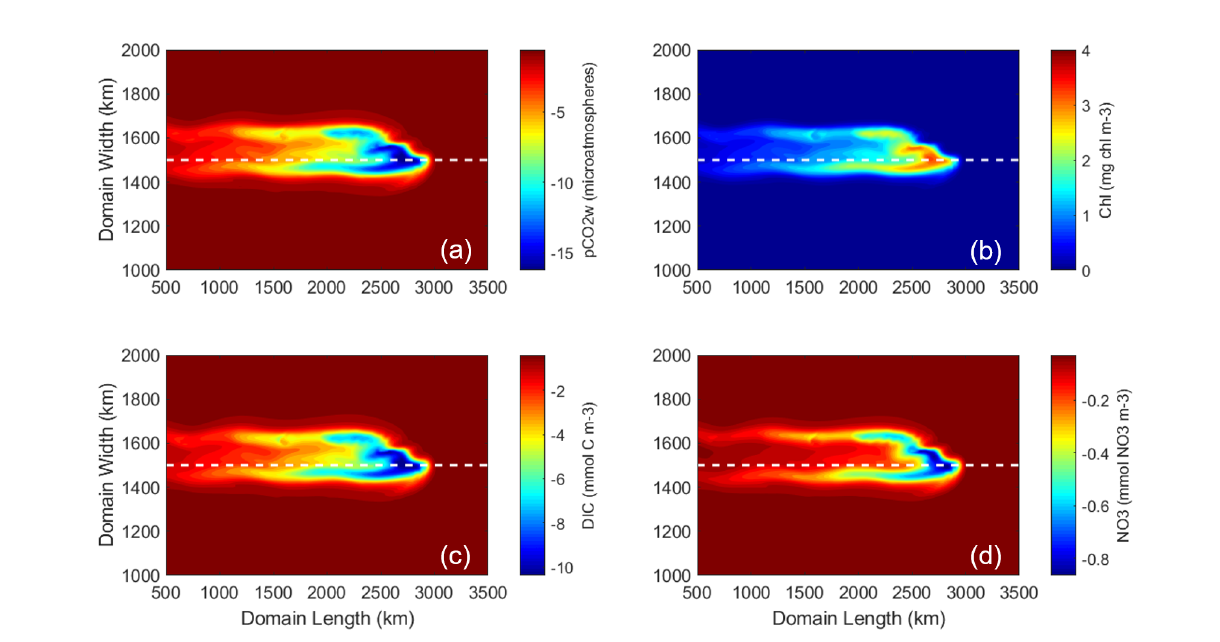
Figure 5. Surface plots of the control simulation results minus S1 (simulation without biological growth) results at day 8, 6 h. ( a ) pCO 2 w ( µ atm). ( b ) Chlorophyll (mg m − 3 ). ( c ) DIC (mmol m − 3 ). ( d ) NO 3 (mmol m − 3